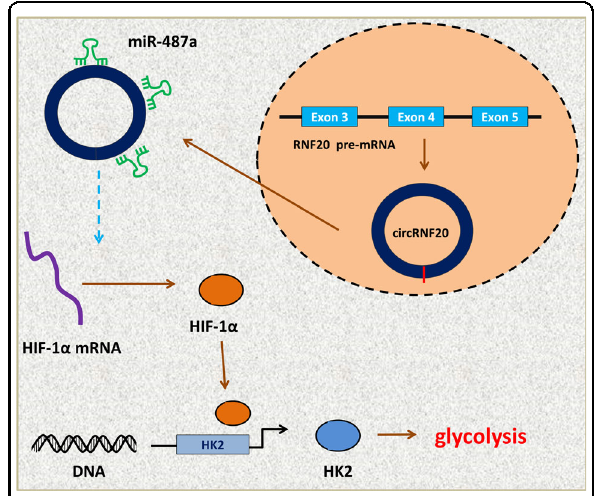
Fig. 6 circRNF20/miR-487a/HIF-1 α /HK2 axis promotes the glycolysis in BC